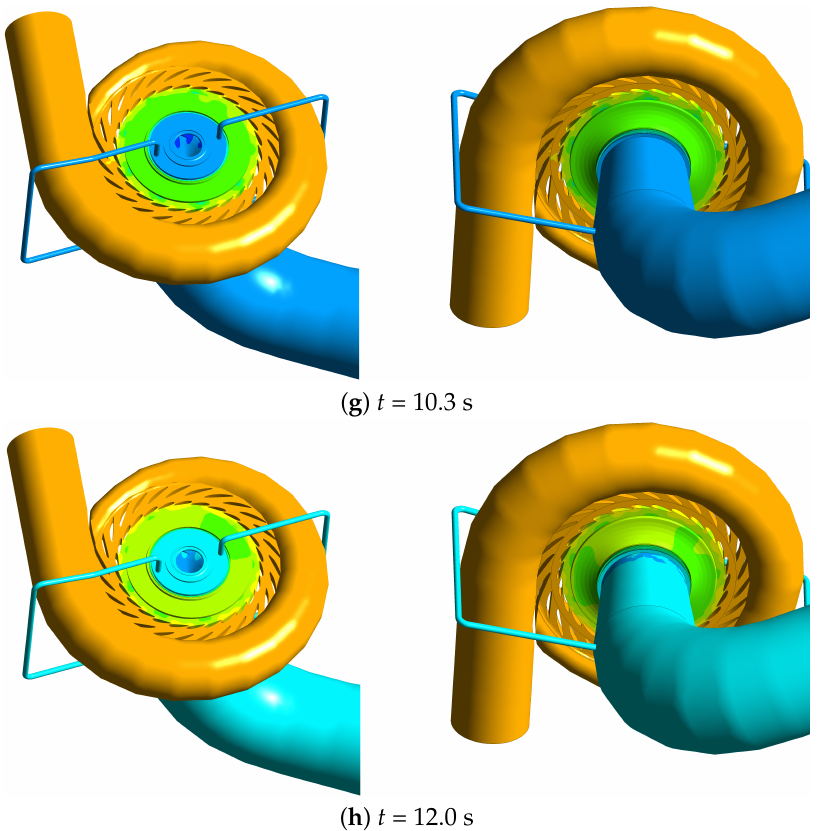
Figure 7. Pressure distribution in the flow passages at different key time moments. According to the pressure sensor installation locations shown in Figure 2, the corre- sponding pressure monitoring points were added to the CFD simulation model to record the pressure values during load rejection at the pressure sensor locations in the vaneless space, crown chamber and band chamber. Figure 8 presents the comparison of the mea- sured and simulated results of the pressure monitoring points at eight calculation times during the load rejection process. It can be seen that the simulation results are in general agreement with the corresponding measurement results.